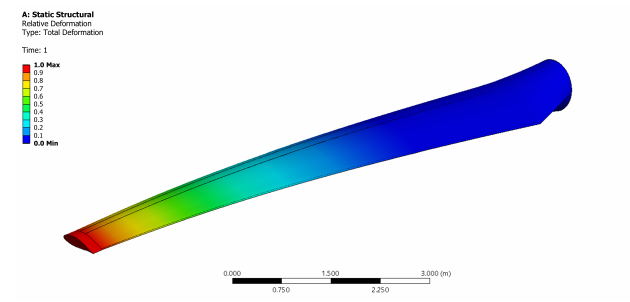
Fig. 3. Deformed result of GFRP